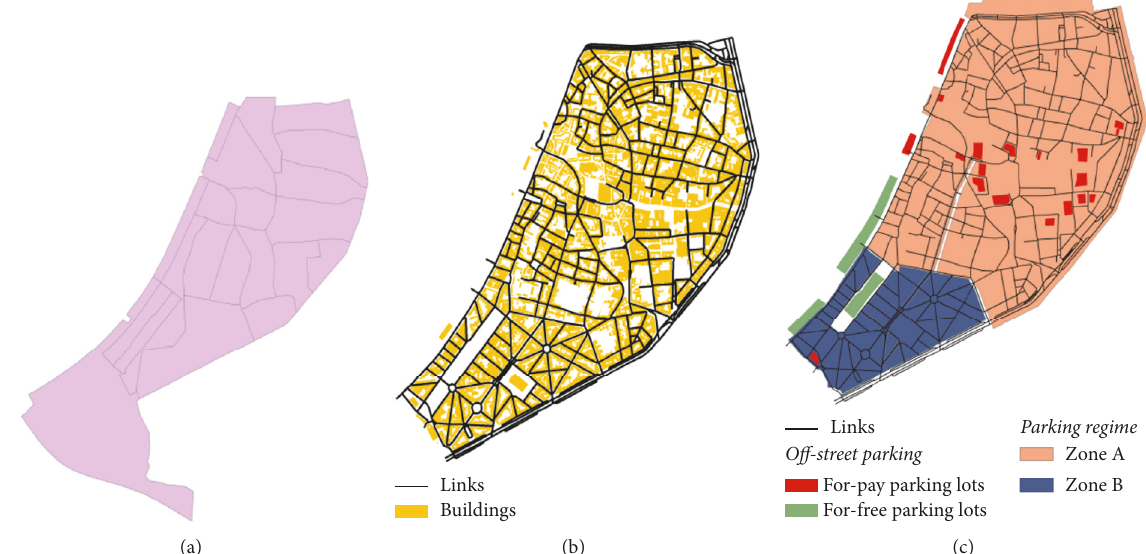
Figure 1: Maps representing (a) the 22 statistical zones used for the Antwerp simulation, (b) the road network and buildings, and (c) parking zones and off-street parking facilities.